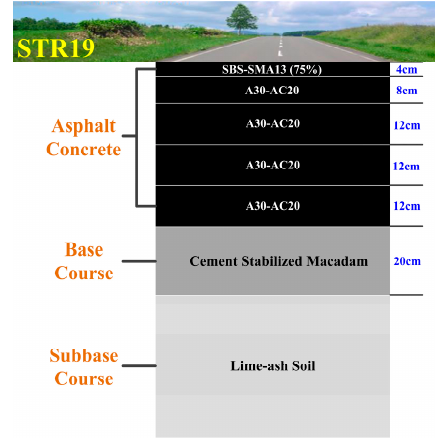
Figure 12. The cross-section of STR19.